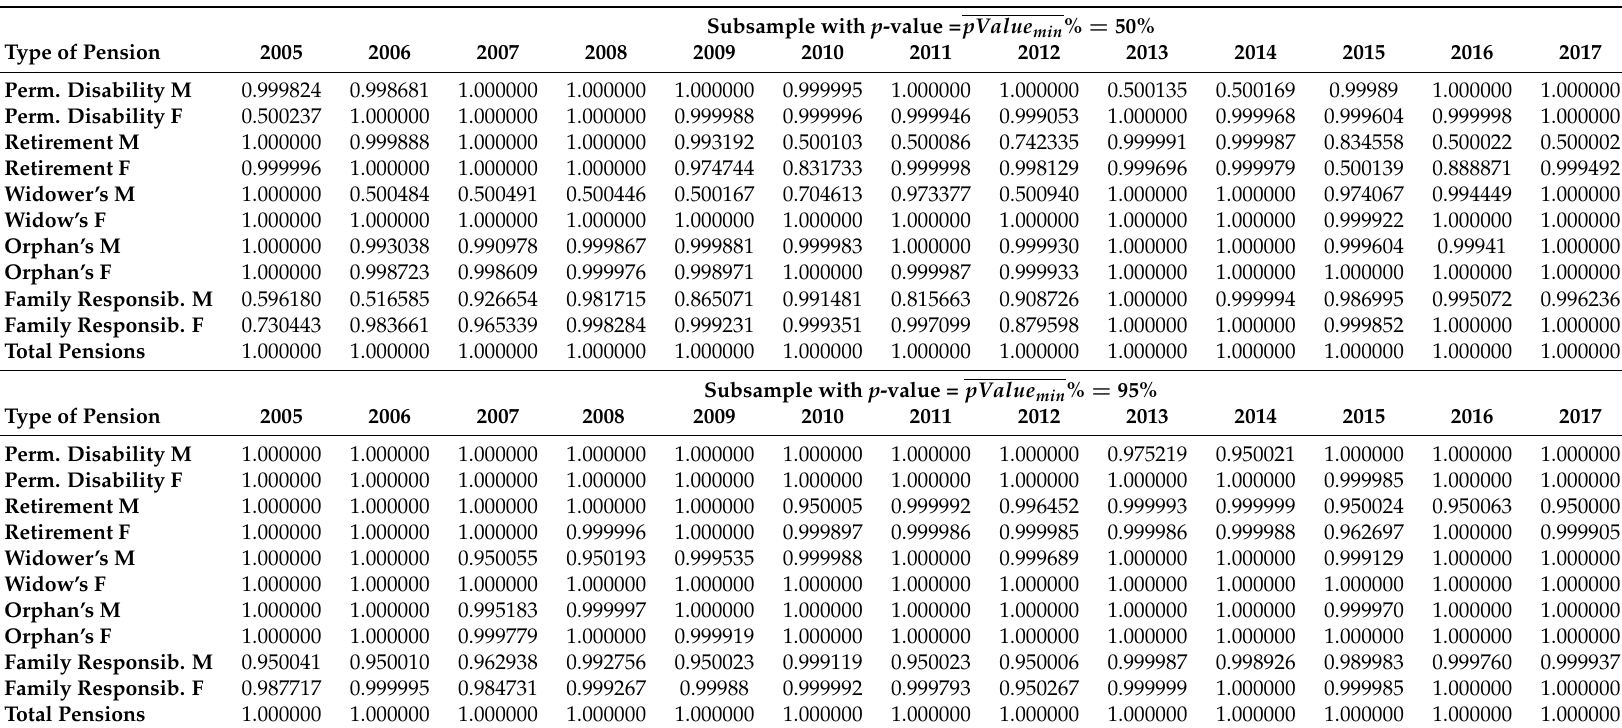
Table 4. Goodness-of-fit test (population/samples) p -values (CSWL and subsamples) M: Male; F: Female. Source: